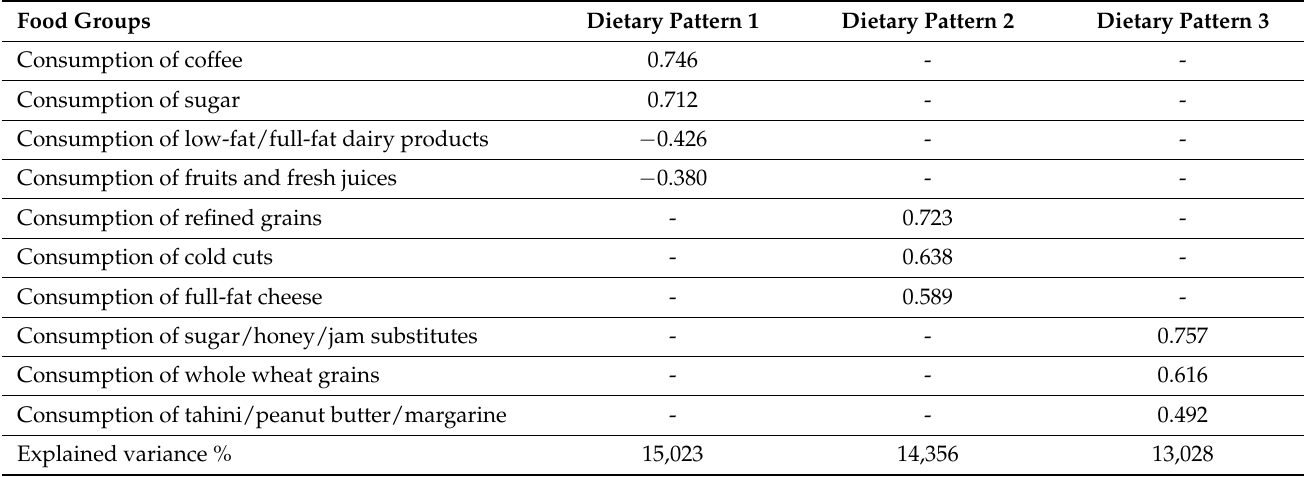
Table 6. Identification of breakfast dietary patterns.